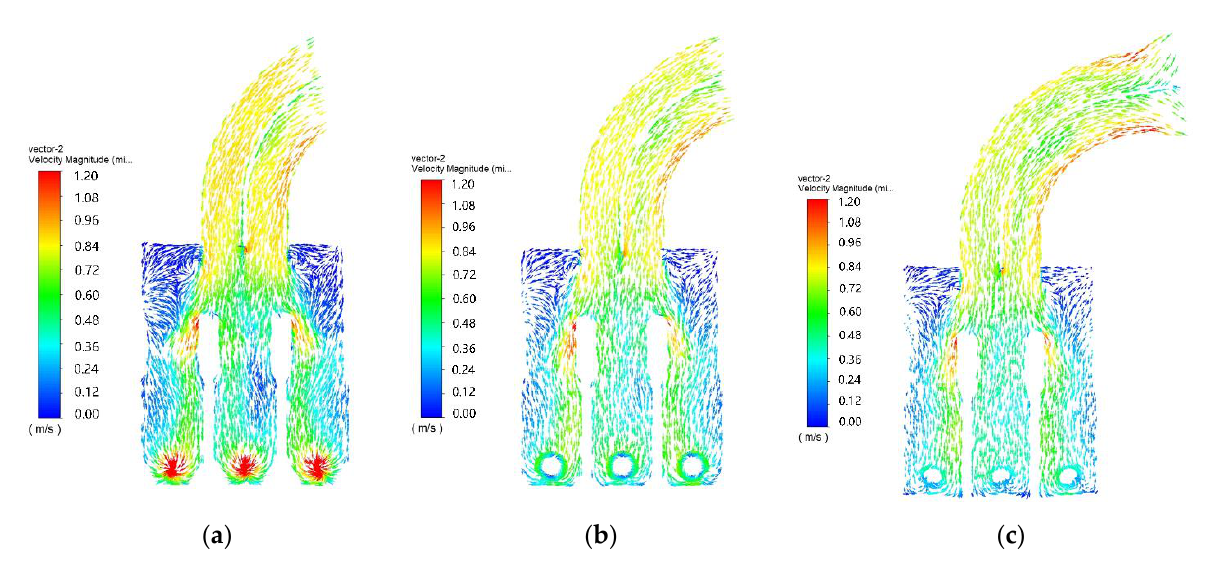
Figure 7. Velocity vector of the characteristic section of the water channel in original design. ( a ) 0.6 m sectional view. ( b ) 1.2 m sectional view. ( c ) 2 m sectional view.